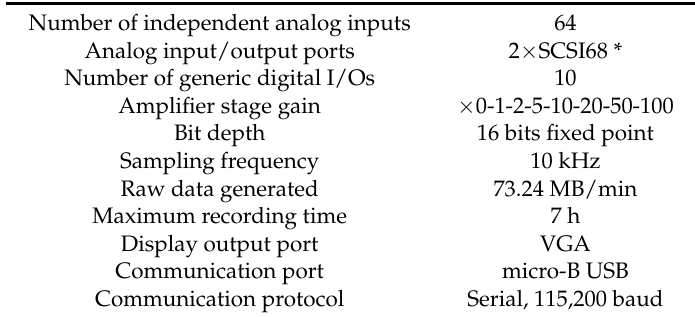
Table 3. Full system